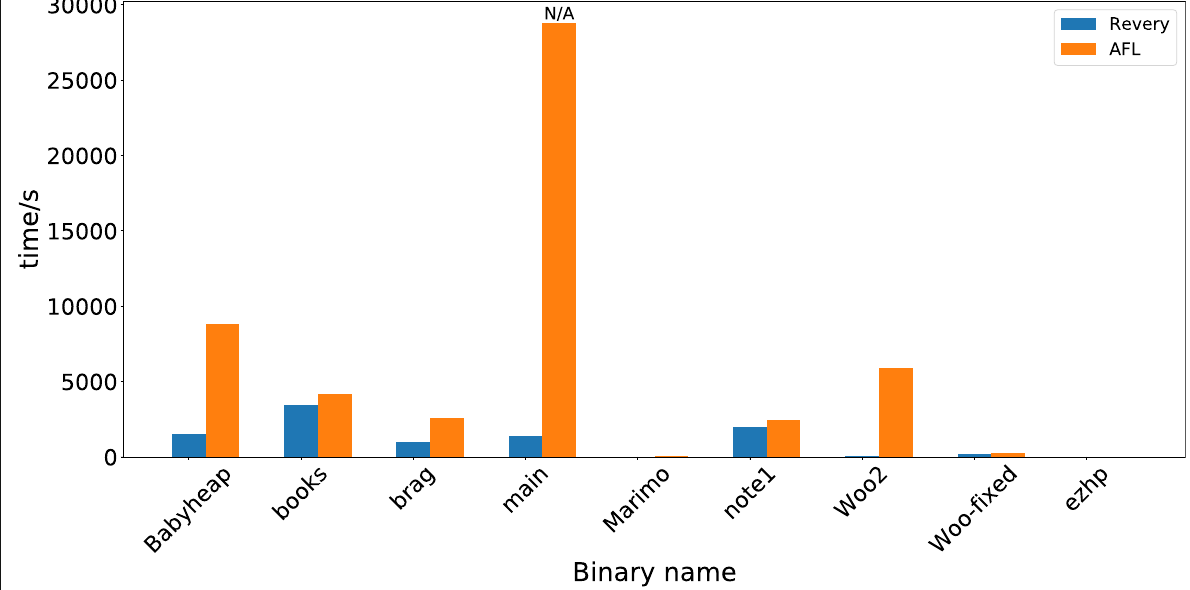
Fig. 10 Time interval for finding first diverging path triggering the layout-contributor slice by Revery , comparing to